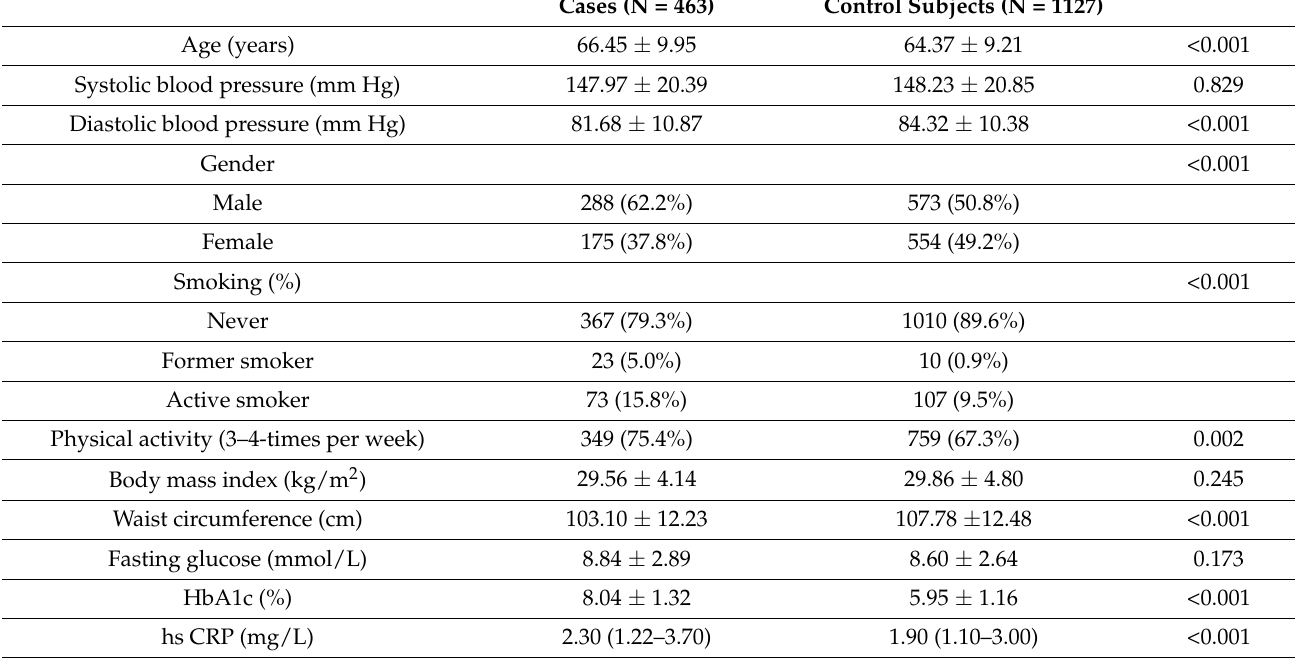
Table 1. Clinical characteristics of patients with T2DM with CAD and subjects with T2DM and without